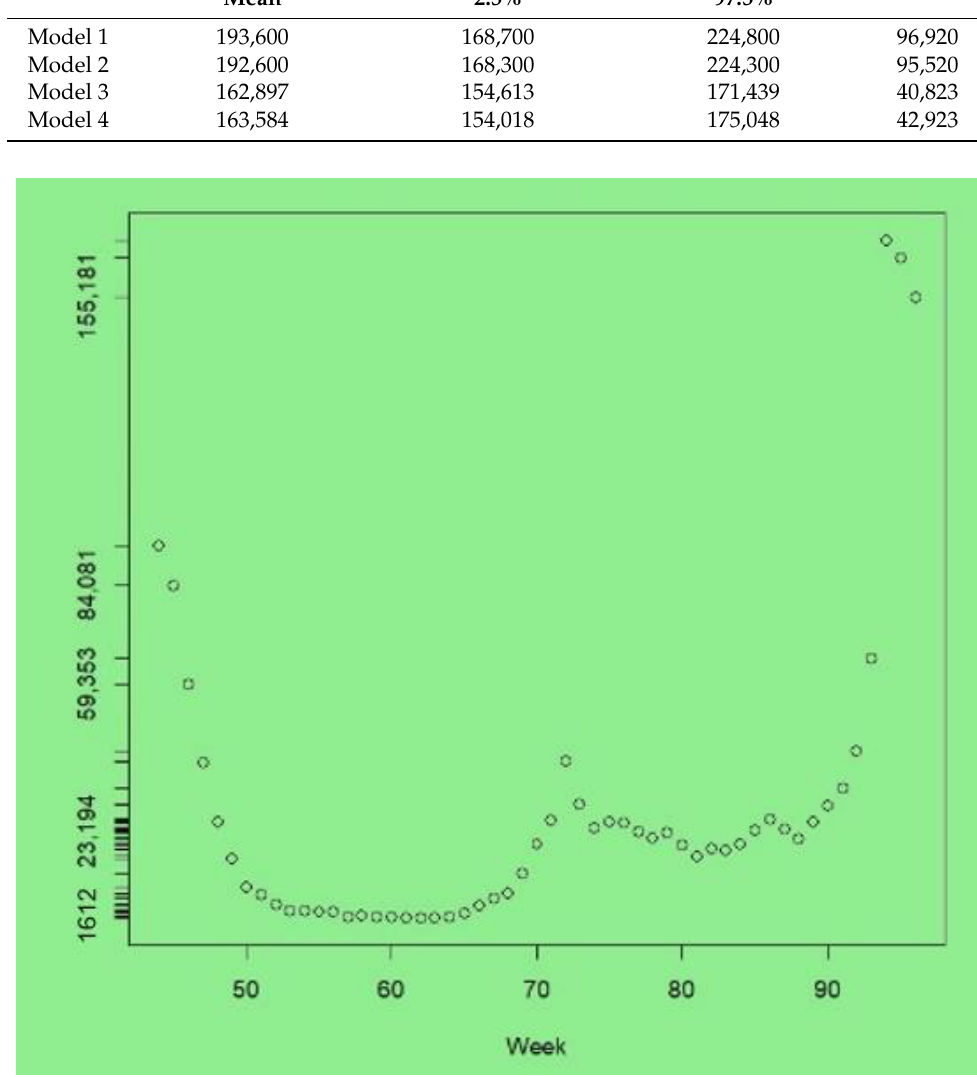
Table 1. Comparative Model Fit, London Boroughs ( N = 32, T=